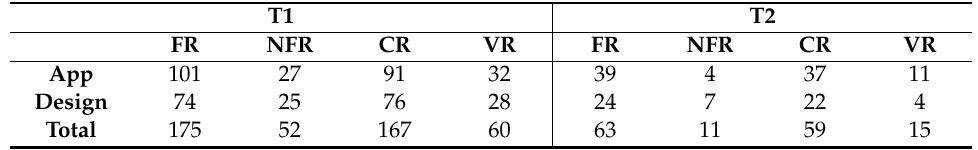
Table 8. Comparison of Team “T1” and Team “T2” over Requirements.